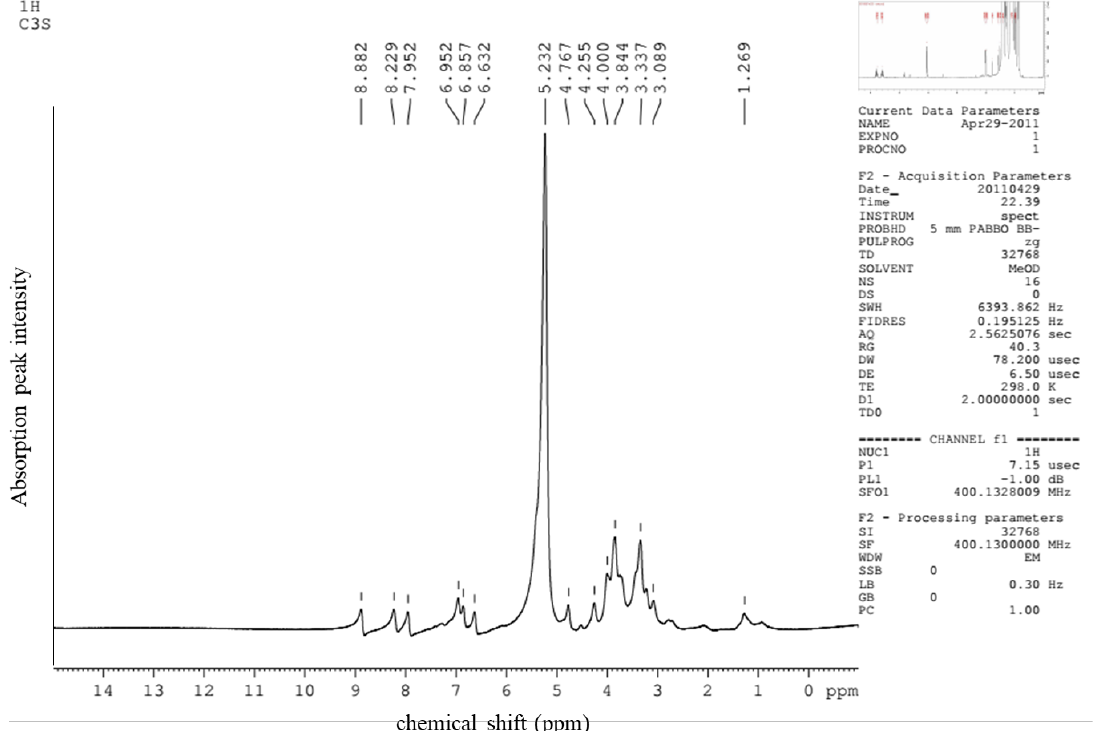
Figure A3. 1 H spectral data (ppm) for the HSCCC-purified cyanidin 3-xylosyl-galactoside.